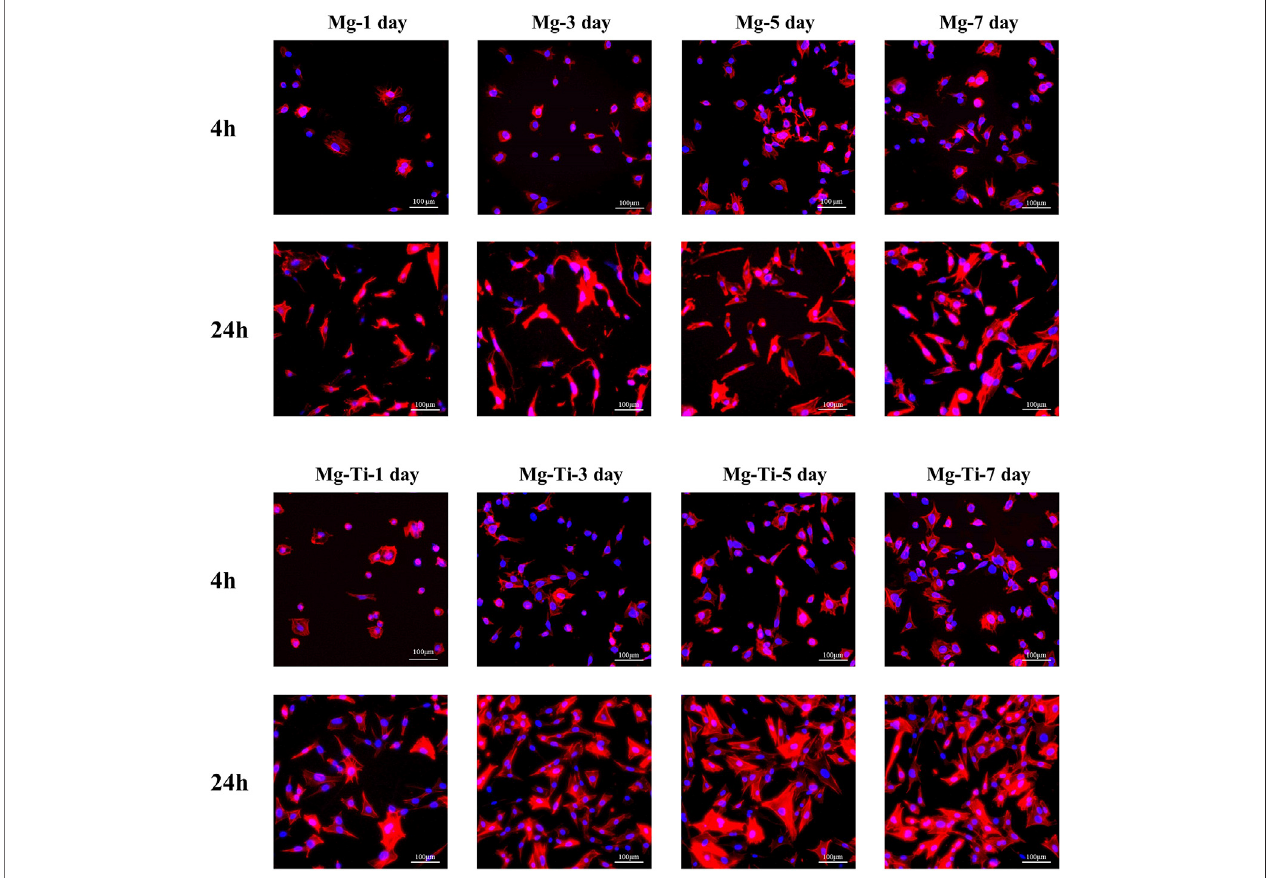
FIGURE 8 | Morphology staining of MC3T3-E1 cells cultured with extracts of the degraded Mg-Ti composite and pure Mg for 4 and 24 h.